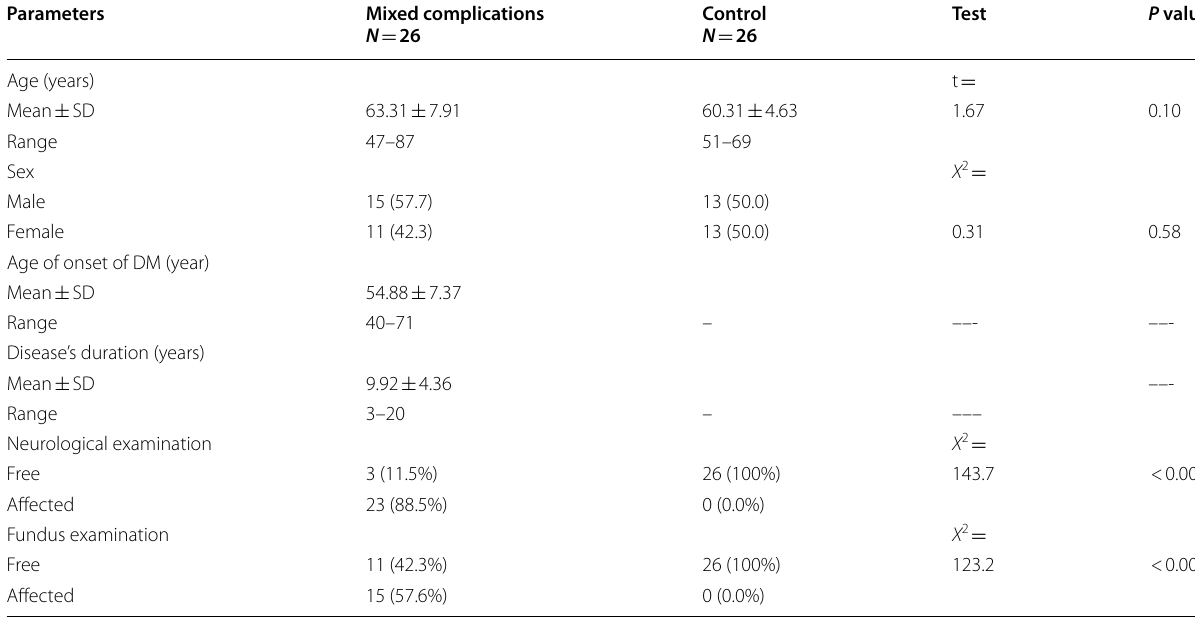
Table 1 Demographic and clinical data of studied